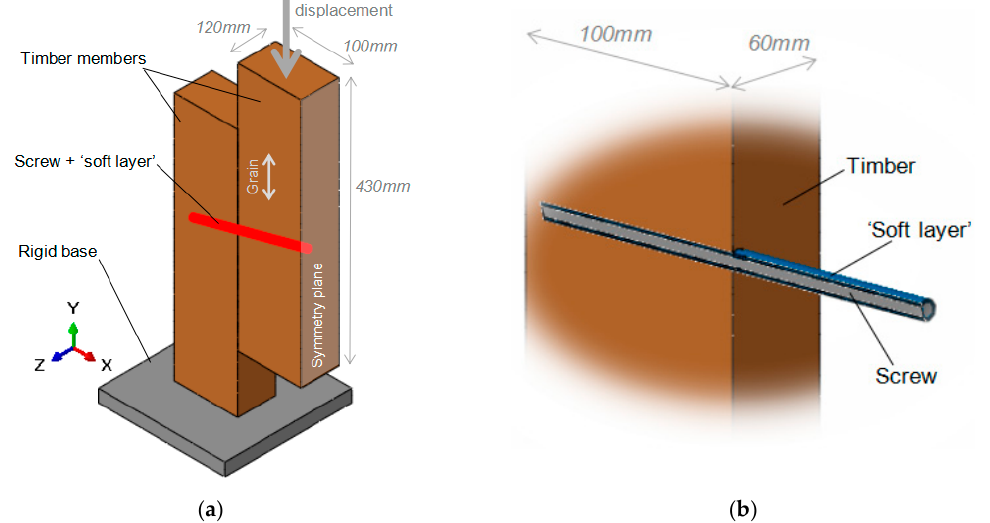
Figure 5. Example of ( a ) typical FE assembly (1/4th the S#1 geometry, with = − 15°) and ( b ) detail of the STS region (ABAQUS/Explicit, hidden mesh pattern). Reproduced from [21] with permission from